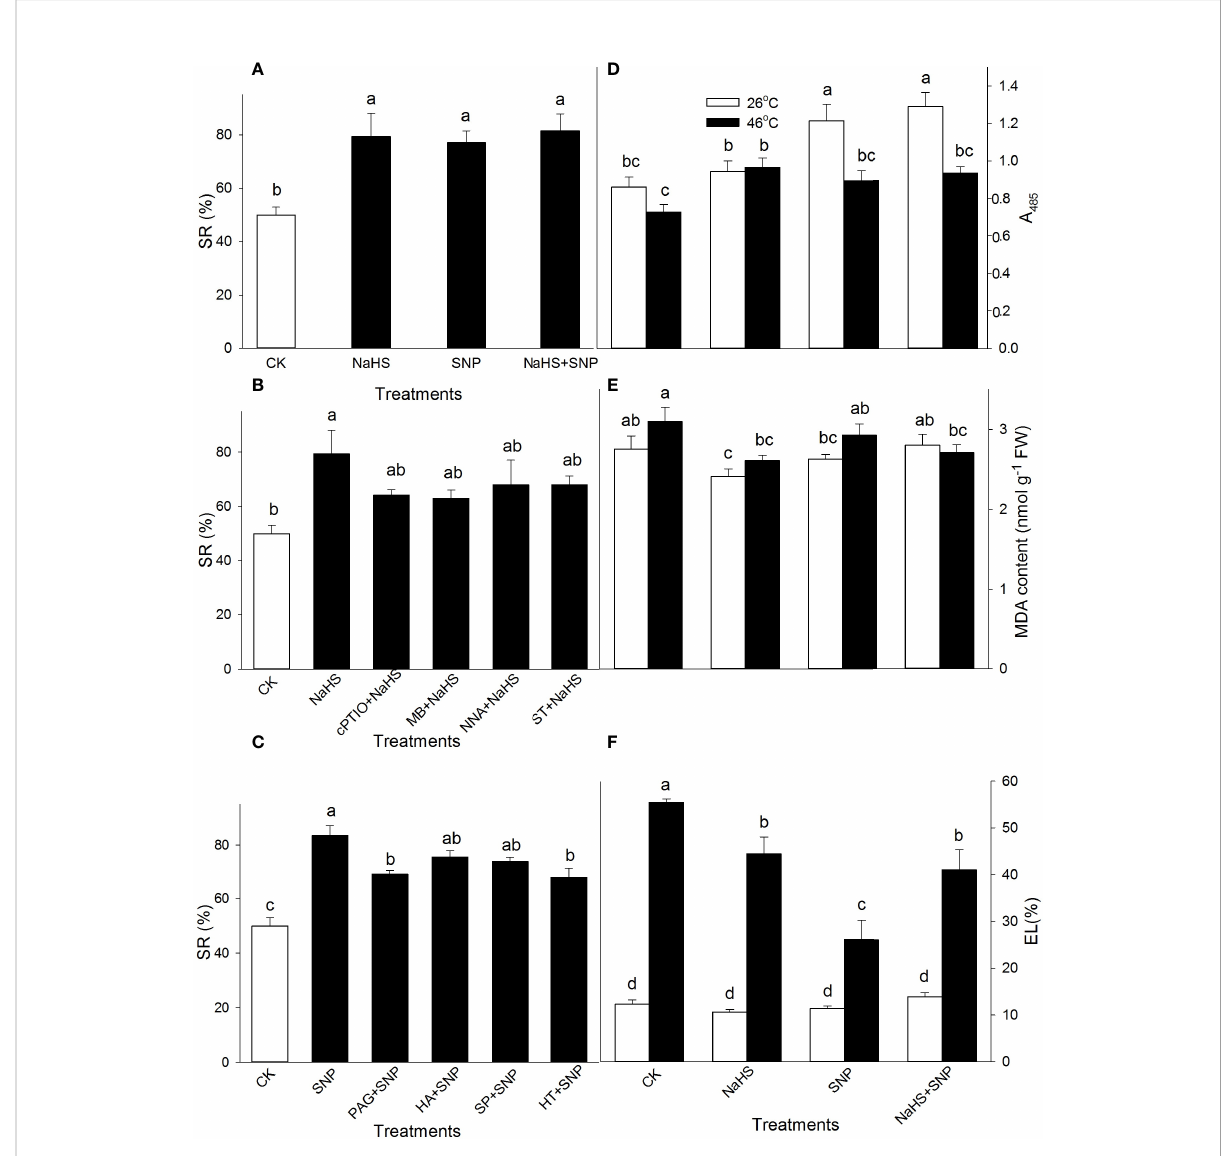
FIGURE 3 Effect of sodium hydrosul fi de (NaHS) alone, or in combination with sodium nitroprusside (SNP), nitric oxide (NO) scavengers and inhibitors as well as SNP alone or in combination with hydrogen sul fi de (H 2 S) inhibitors and scavengers on survival rate (SR) (A – C ), tissue viability (D) , malondiadehyde (MDA) (E) , and electrolyte leakage (EL) (F) in maize seedlings under non-HS and HS conditions. The data had at least three biological replicates and were tested using Duncan's multiple-range test at 0.05 signi fi cant level, which denote means ± standard error (SE). The bars with the different letters represent signi fi cant differences, while the same letters represent no signi fi cant